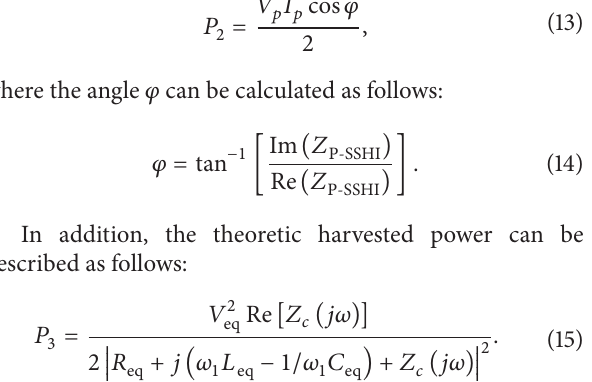
Figure 10: Comparison of frequency responses of harvested power from the two classes of coupled